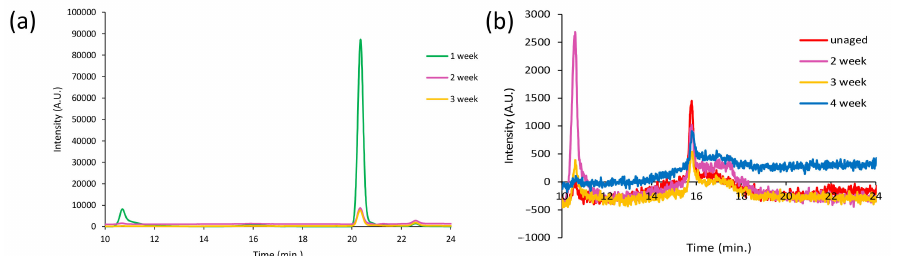
Figure 16. SEC chromatograms (10–24 min) of the DCM extracts of HDPE-0w (red), HDPE-1w (green), HDPE-2w (purple), HDPE-3w (yellow), and HDPE-4w (blue) acquired with a refractive index (RI) detector ( a ) and at 260 nm ( b